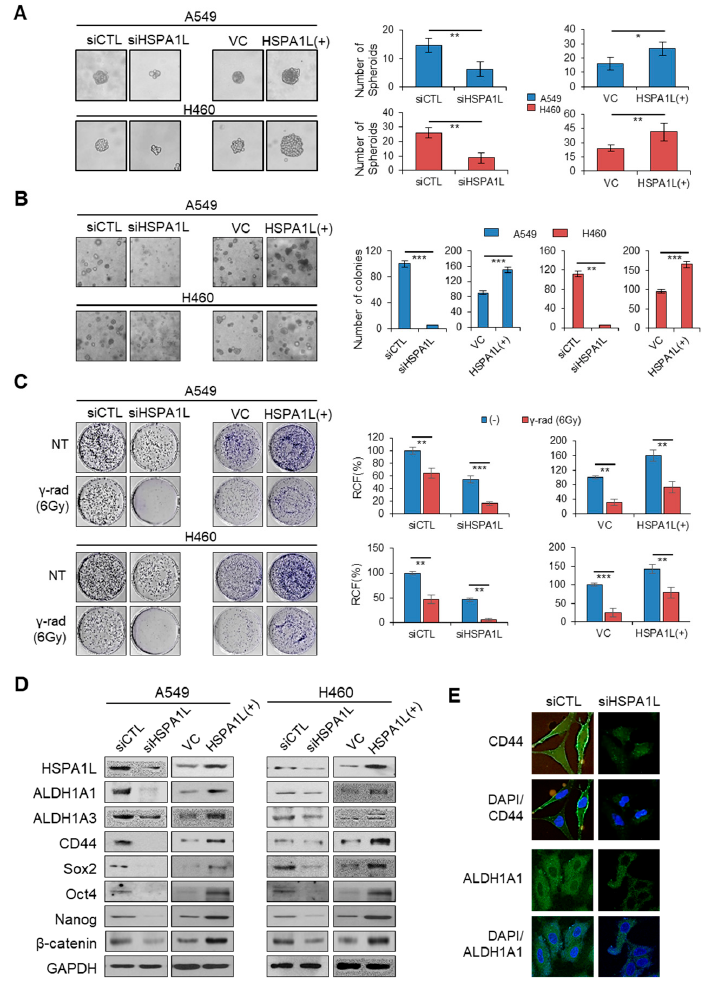
Figure 2. HSPA1L regulates stemness and γ -radiation resistance of lung cancer cells. ( A ) Sphere-forming capacity in A549 and H460 cells transfected with siRNA targeting the HSPA1L and pcDNA-HSPA1L expression vector. ( B ) Anchorage-independent colonization in A549 and H460 cells transfected with siRNA targeting the HSPA1L and pcDNA-HSPA1L expression vector. Cells were photographed under phase-contrast microscopy and quantified. ( C ) Quantification of colony-forming ability in A549 and H460 cells transfected with HSPA1L-targeting siRNA and pcDNA-HSPA1L expression vector; 1 × 103 cells were plated on 35-mm culture dishes 48 h after transfection. Cells were irradiated 24 h later with a single dose of 6 Gy (Dose rate of 0.2 Gy/min). Cells were incubated for 10 days, and colonies were stained with crystal violet and counted, and the relative colony-forming percentage was plotted. ( D ) Western blot analysis of CSC markers ALDH1A1, ALDH1A3, CD44, Sox2, Oct4, Nanog, and β -catenin. GAPDH was used as a loading control. ( E ) Immunocytochemistry analysis of CD44 and ALDH1A1 after transfection with siRNA targeting HSPA1L in A549 cells. Data represent the mean ± SD of three independent experiments using a two-tailed t-test. * p < 0.05, ** p < 0.01, *** p <